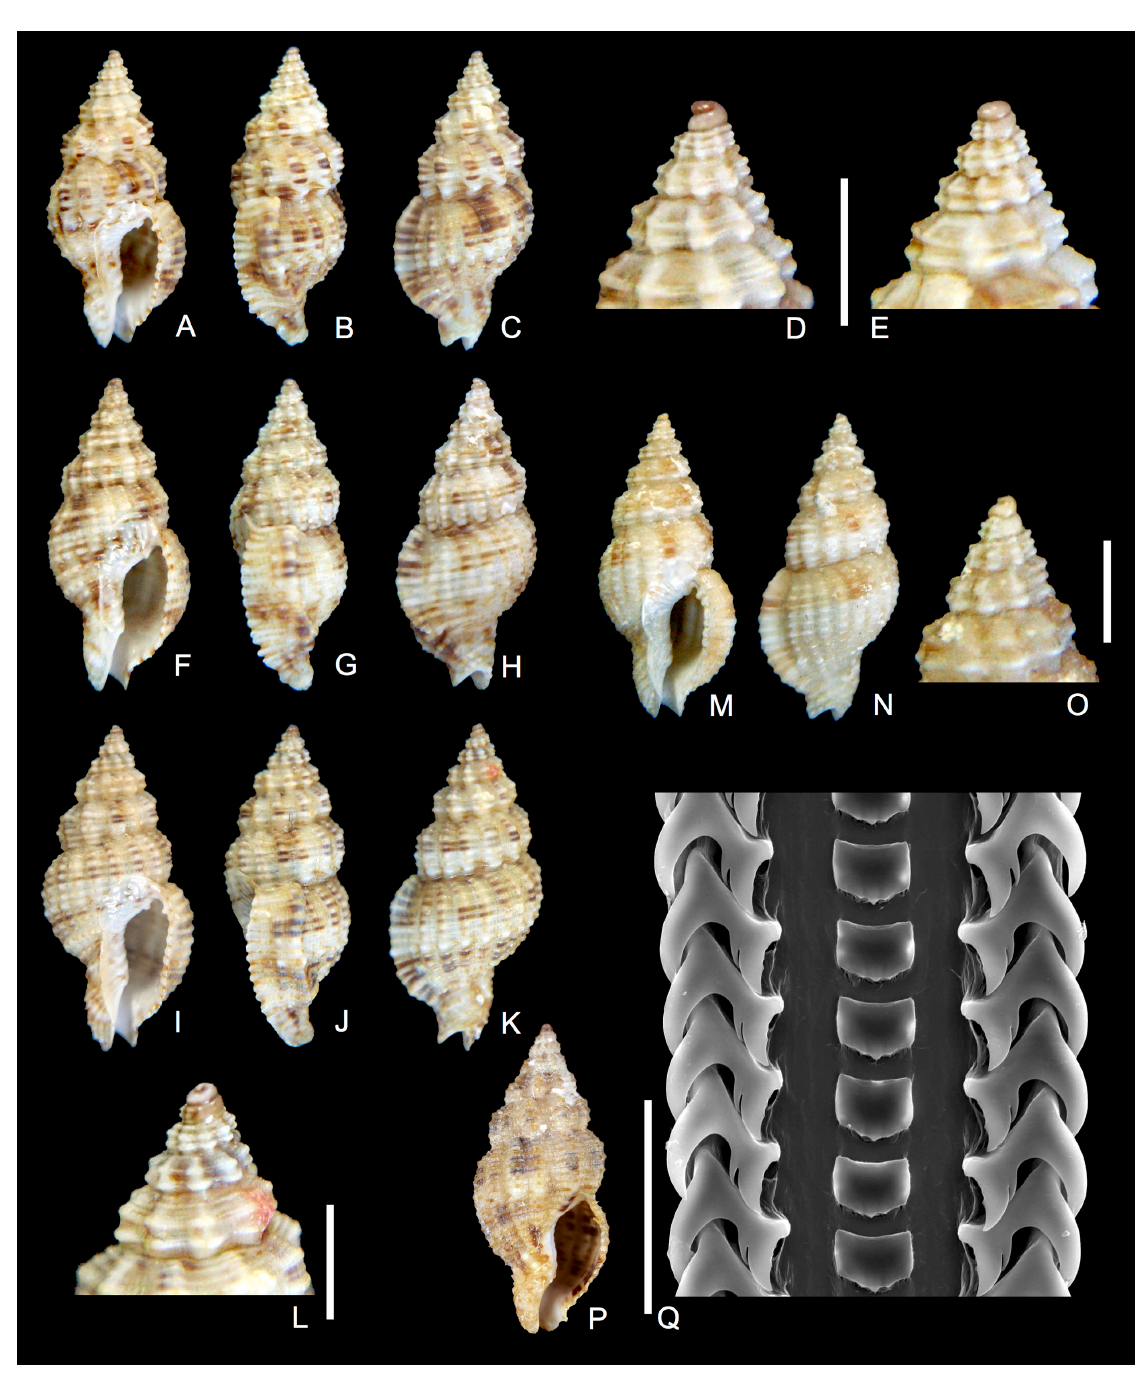
Fig. 1. Sinetectula egregia (Reeve, 1844) gen. et comb. nov. A–E . Specimen from the Marshall Islands, Kwajalein Atoll, in cave at Oceanside of West reef, depth 12 m, 12.0 mm long (KF 4756). F–H . Specimen with same collection data as for preceding, 14.5 mm long (KF 4756). I–L . Specimen from Indonesia, Sulawesi, 1°08′ N, 121°51′ E, near Pulau Raja, depth 5–40 m, 16.9 mm long (KF 4854). M–O . Specimen from Mayotte, Pananzi Island, BENTHEDI 1977 stn 32, 12°45′ S, 45°18′ E, depth 15–20 m, 15.0 mm long (MNHN). P . Specimen from Papua New Guinea, Madang, Astrolabe Bay, PAPUA NIUGINI stn PB14, 5°13.8′ S, 145°48′ E, depth 15 m, 16.6 mm long (MNHN IM-2013-12540). Q . Radula of preceding specimen. A–P. Images courtesy of MNHN – Alexandre Lardeur. Q. Image courtesy of Yuri Kantor. Scale bars: D–E, L, O = 2.0 mm; Q = 100